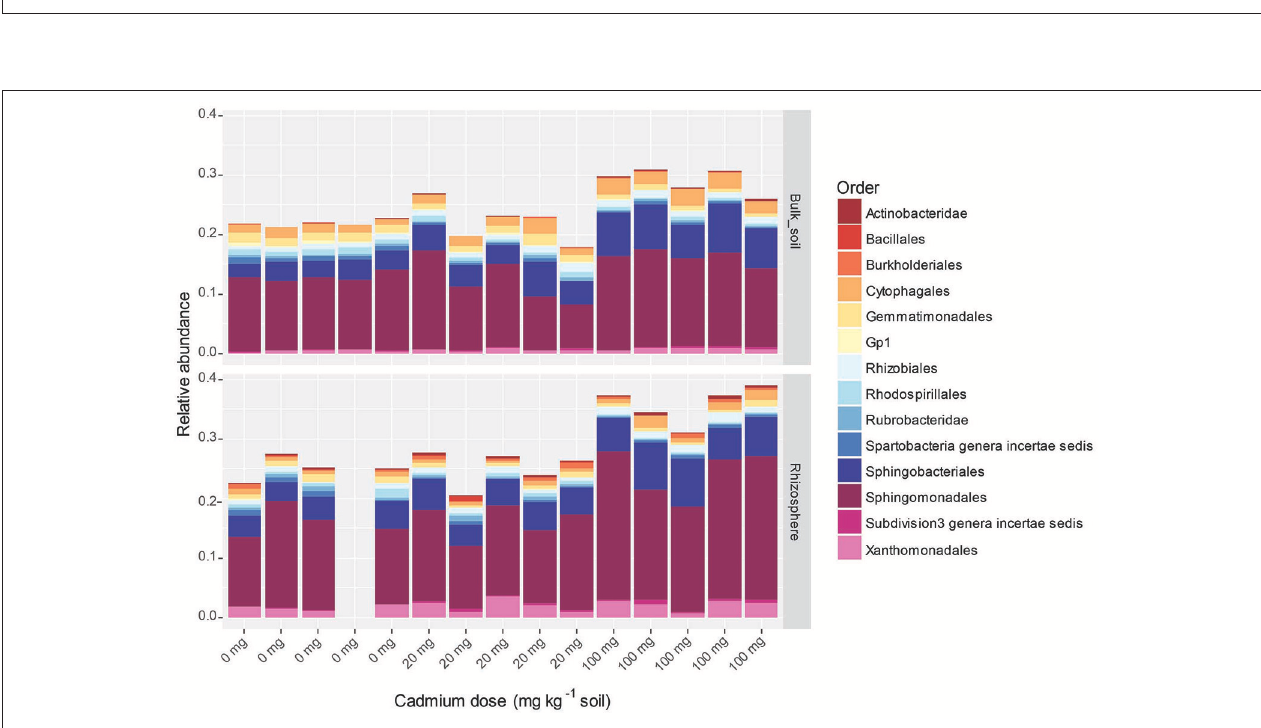
FIGURE 4 | Relative abundance of OTUs found to respond significantly ( p < 0.05) to the presence of rhizosphere at 0, 20, and 100mg Cd kg − 1 soil. OTUs are clustered by order. Only orders that represented > 0.5% of the total community are represented. Absent bar represents replicate that was excluded due to under sampling. Orders denoted as Gp “X” are groups belonging to the phylum Acidobacteria.